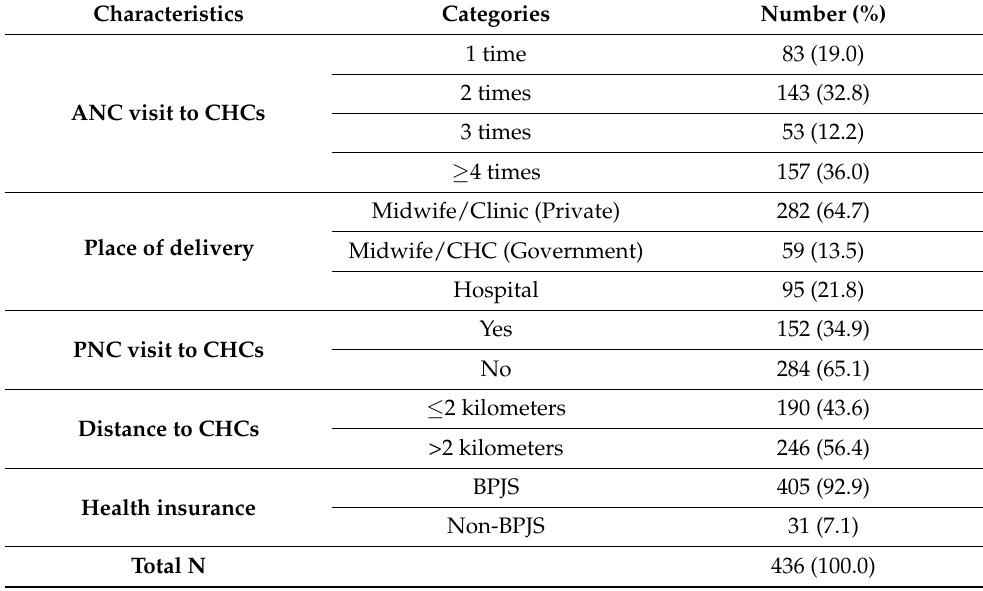
Table 2. Maternal health services utilization of the respondents, Municipality of Jambi, Municipality of Sungai Penuh, Merangin Regency, Province of Jambi, 2021 (n =